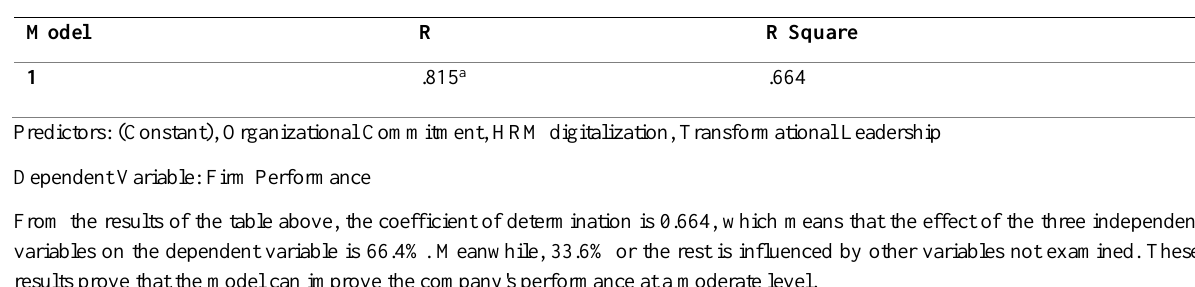
Table 6: Results of Determinant Coefficient